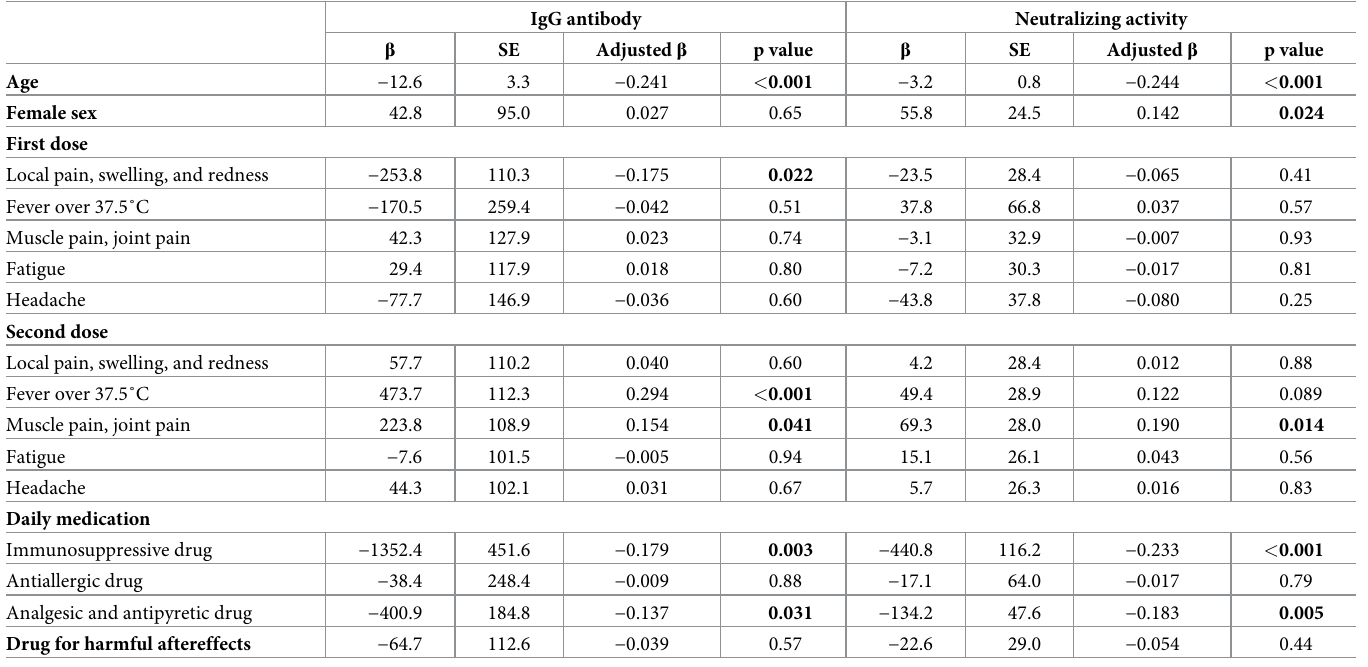
Table 3. Multivariable linear regression analysis for IgG antibody against the SARS-CoV-2 spike protein titers and neutralizing activity. IgG